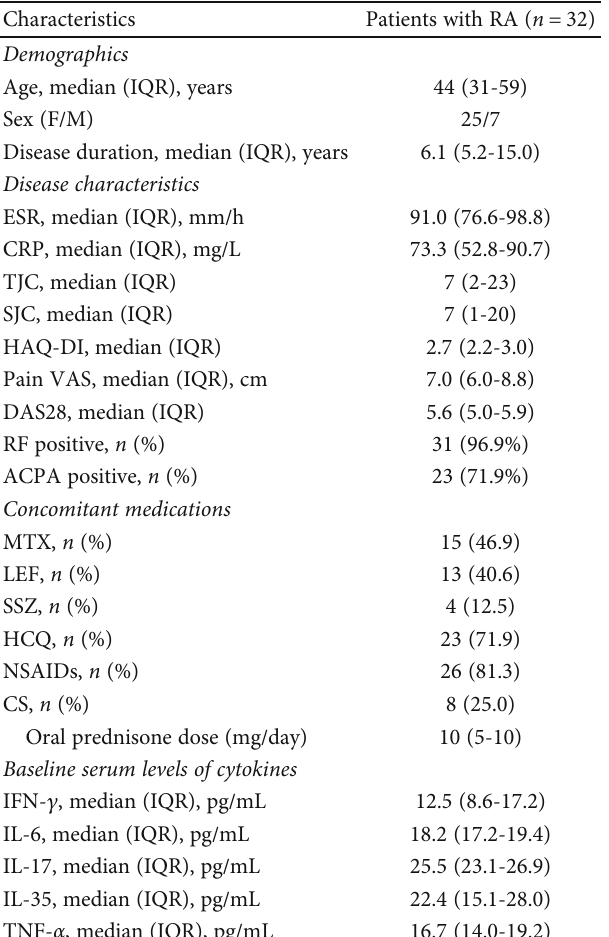
Table 1: Baseline characteristics of patients with RA.